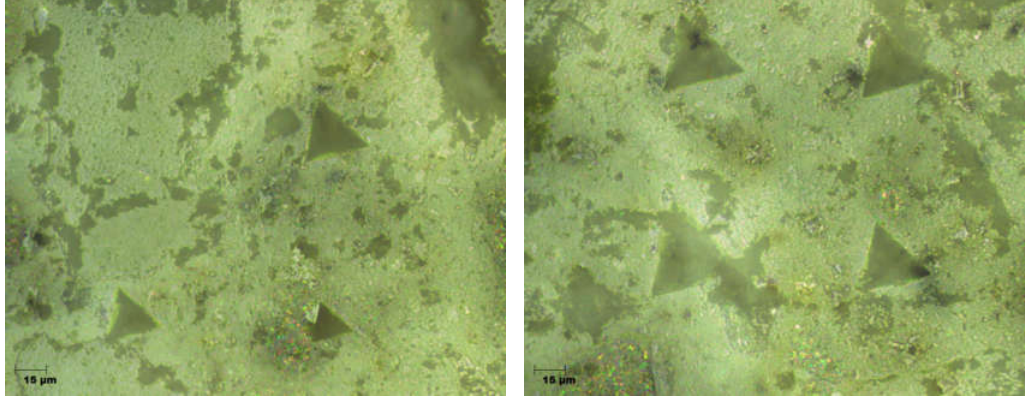
Figure 19. Exemplary photos of surface with trial indentations.